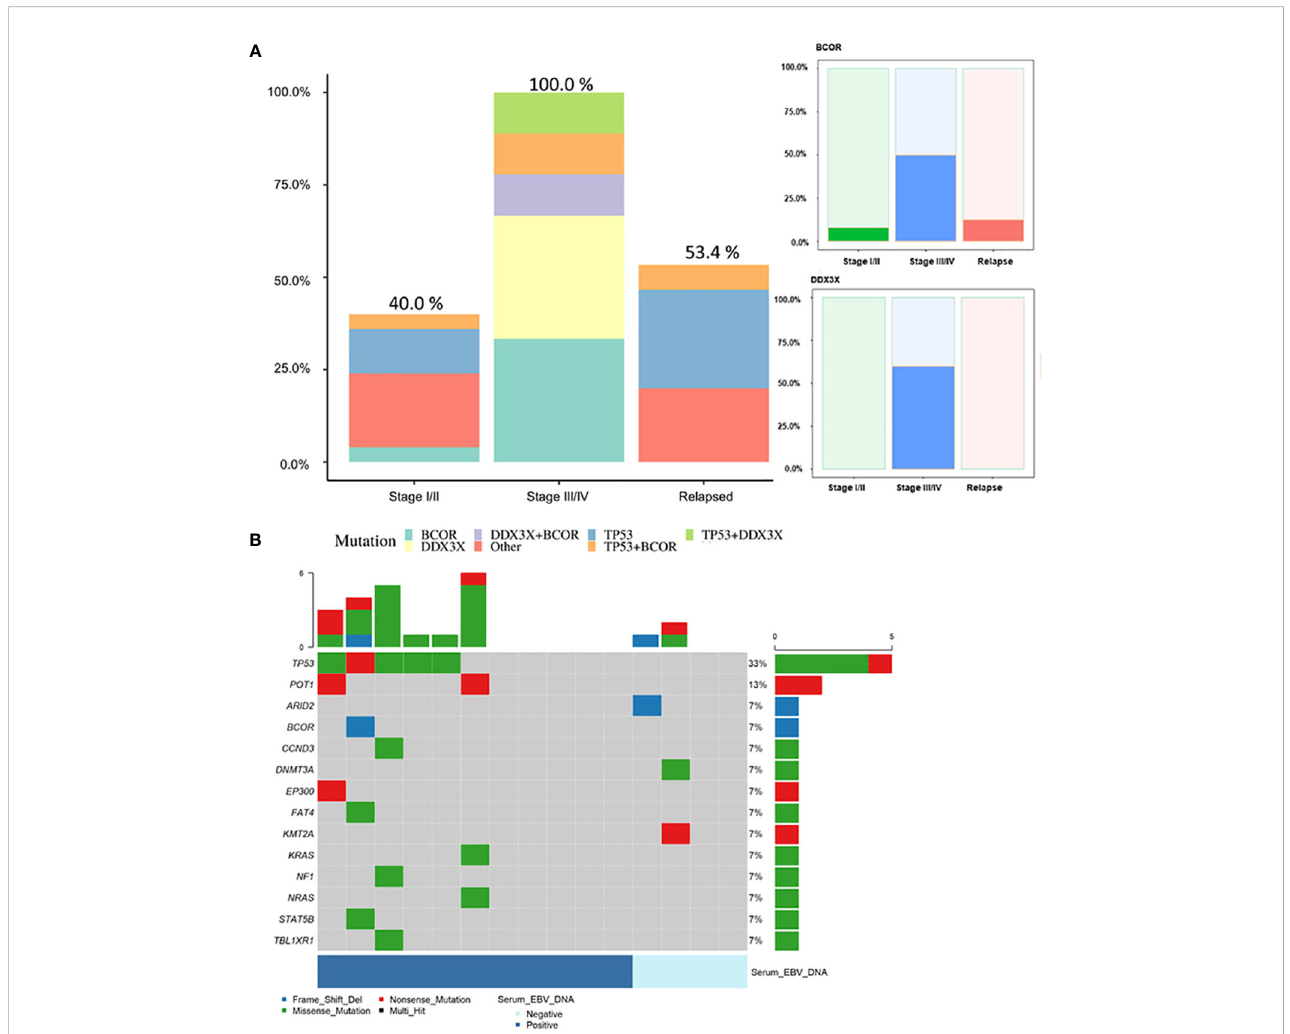
FIGURE 2 (A) Frequencies of genetic mutations in each of the TP53, DDX3X , and BCOR genes and other genes according to patient clinical status. Mutations of DDX3X and BCOR showed higher frequency in advanced-stage compared to early-stage or relapsed patients ( P = 0.01 and P < 0.001, respectively). (B) Mutational pro fi le of samples from patients with relapsed ENKTL (n = 15). Number and prevalence of mutated cases. Samples included baseline samples from 11 patients with a history of chemotherapy at other institute and four patients who had already undergone baseline sampling prior to treatment and for whom recurrence was con fi rmed during follow-up. Among the four patients who already underwent pretreatment sampling, ctDNA mutation was detected in only one. In this patient, the mutation spectrum was different between the pretreatment ( DDX3X mutation detected) and relapsed (no mutation detected)